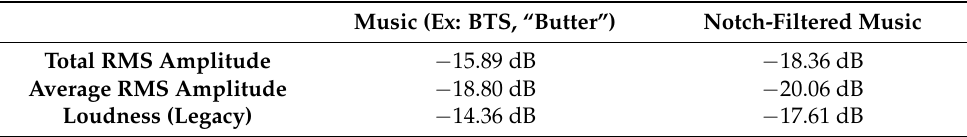
Table 3. Statistical data on average root mean square (RMS) and loudness change of the notch-fil- tered music.